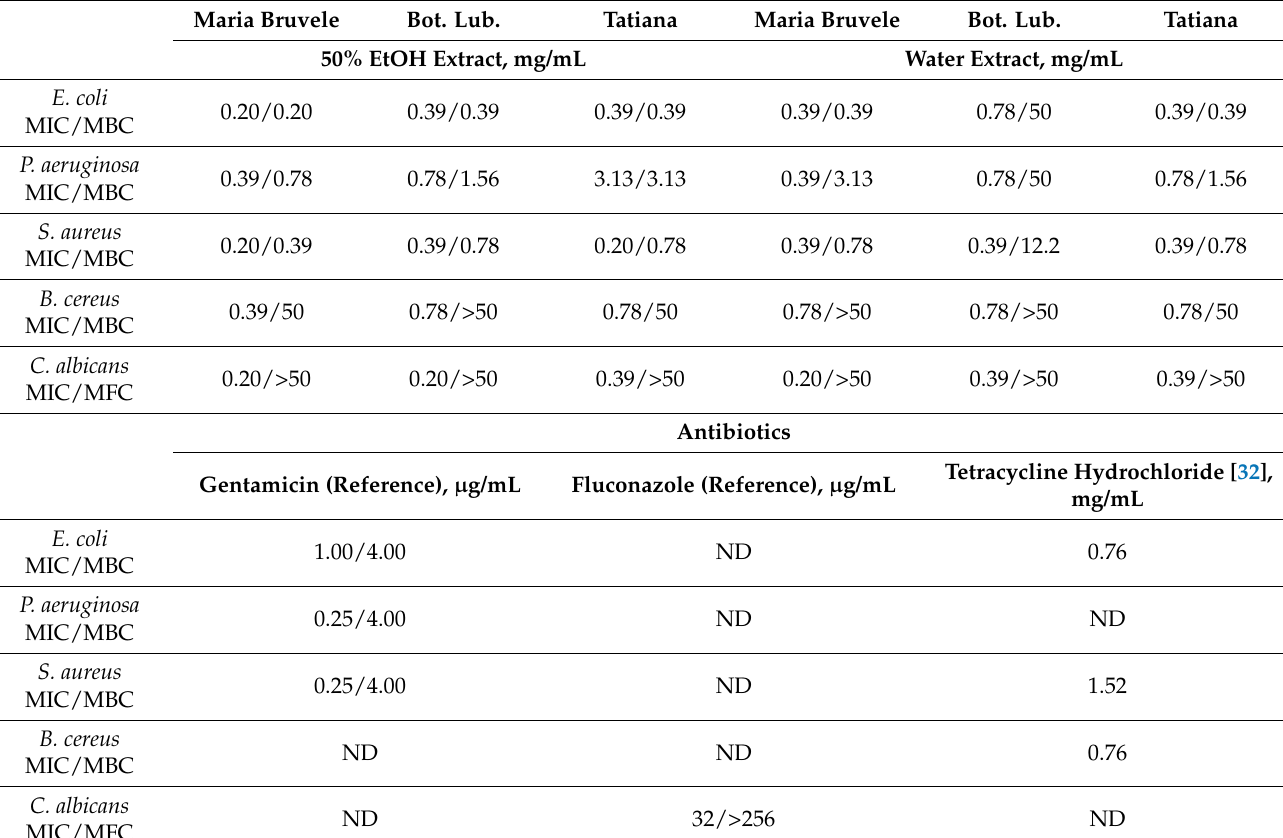
Table 3. Antimicrobial activity of the extracts from SBT